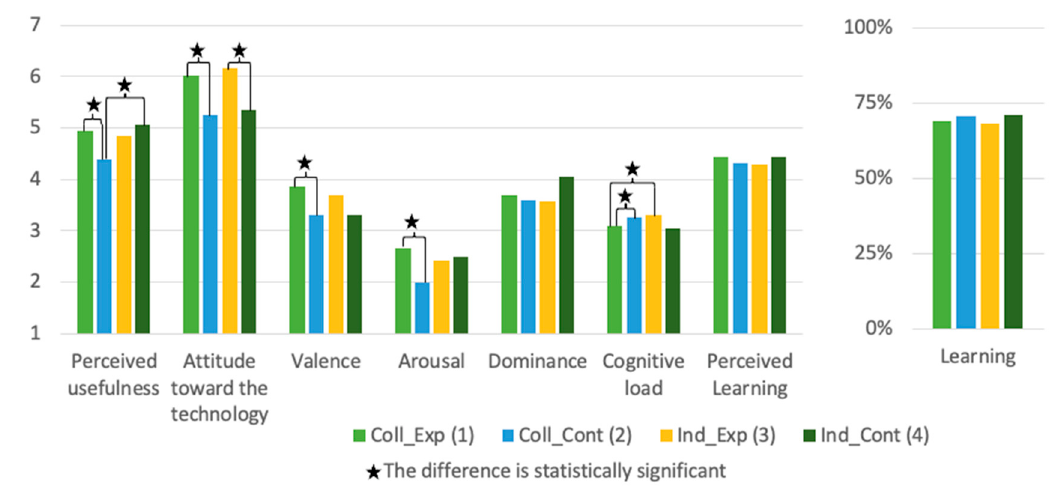
Figure 7. Graph of the average value of all but physiological variables and their statistical significance ( p < 0.05).